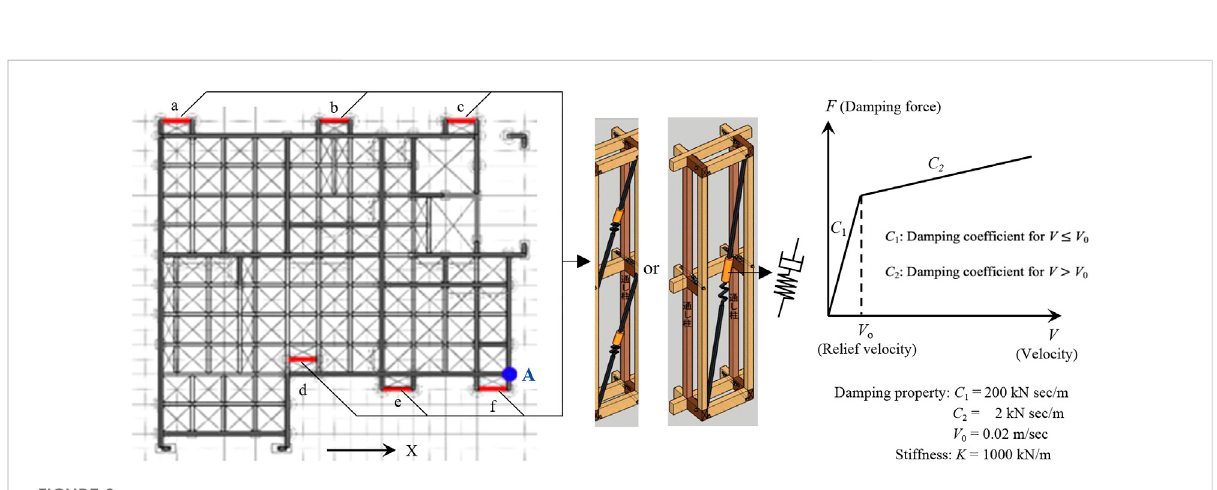
FIGURE 9 Layout of viscous dampers and damping